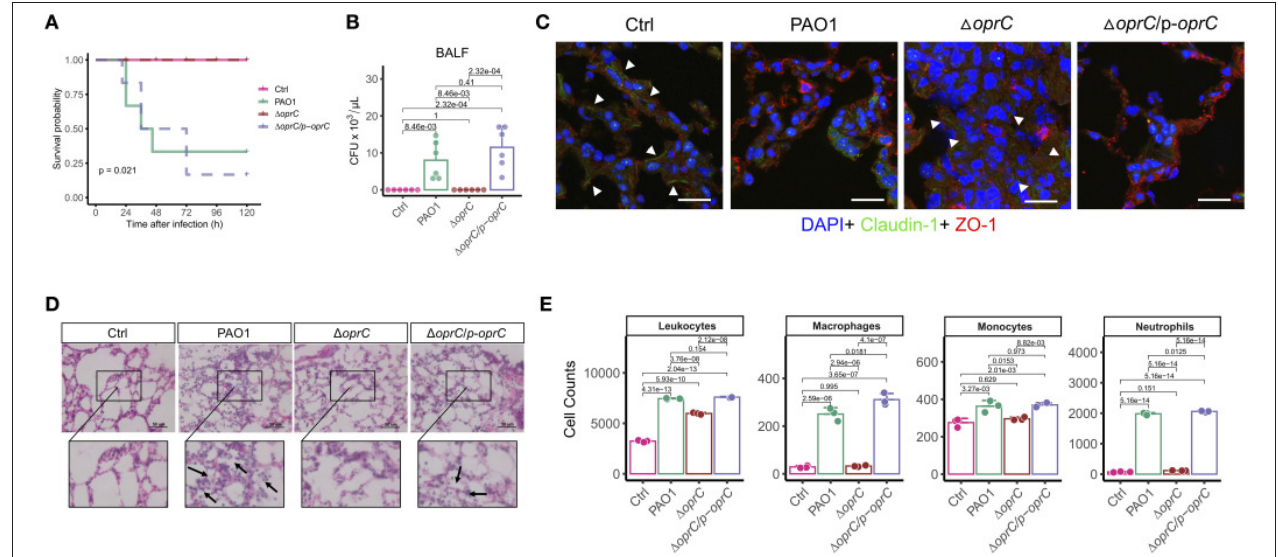
FIGURE 3 | 1 oprC infection decreased mouse mortality and lung damage following P. aeruginosa infection. (A) C57BL6 mice were intranasally challenged with wild type PAO1, 1 oprC , and complemented strain at 2 × 10 7 CFU in 25 µ L PBS; moribund mice were killed to obtain survival data ( n = 6). (B) Bacterial burdens in the BALF were determined 24h after bacterial infection ( n = 6). (C) Representative images of immunofluorescence staining of the lungs infected with bacteria for Claudin-1 co-stained with ZO-1 and DAPI ( n = 3). Arrowheads show the membrane localization of Claudin-1. Scale bars, 20 µ m. (D) Representative histological views of the lungs of mice 24h after intranasal infection with bacteria by H&E staining (insets show the enlarged views) ( n = 3). Arrows show examples of neutrophil infiltration areas. Scale bars, 50 µ m. (E) Quantification of leukocytes, macrophages, monocytes, and neutrophils numbers per 30,000 cells collected from lung infected with bacteria for 24h. Error bars represent the mean ± s.d. Kolmogorov-Smirnov test was performed for survival curves analysis. One-way ANOVA with a post-hoc Tukey test was performed for comparison of means of groups in other